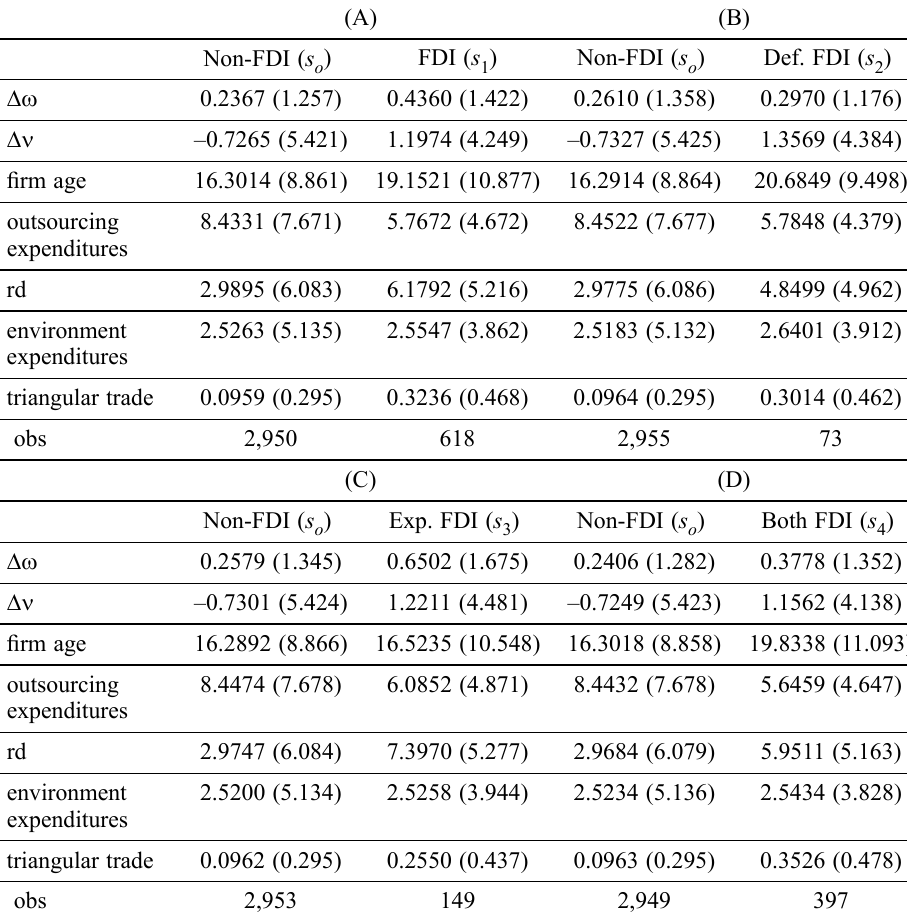
Table 2. Summary statistics by different types of outward FDI